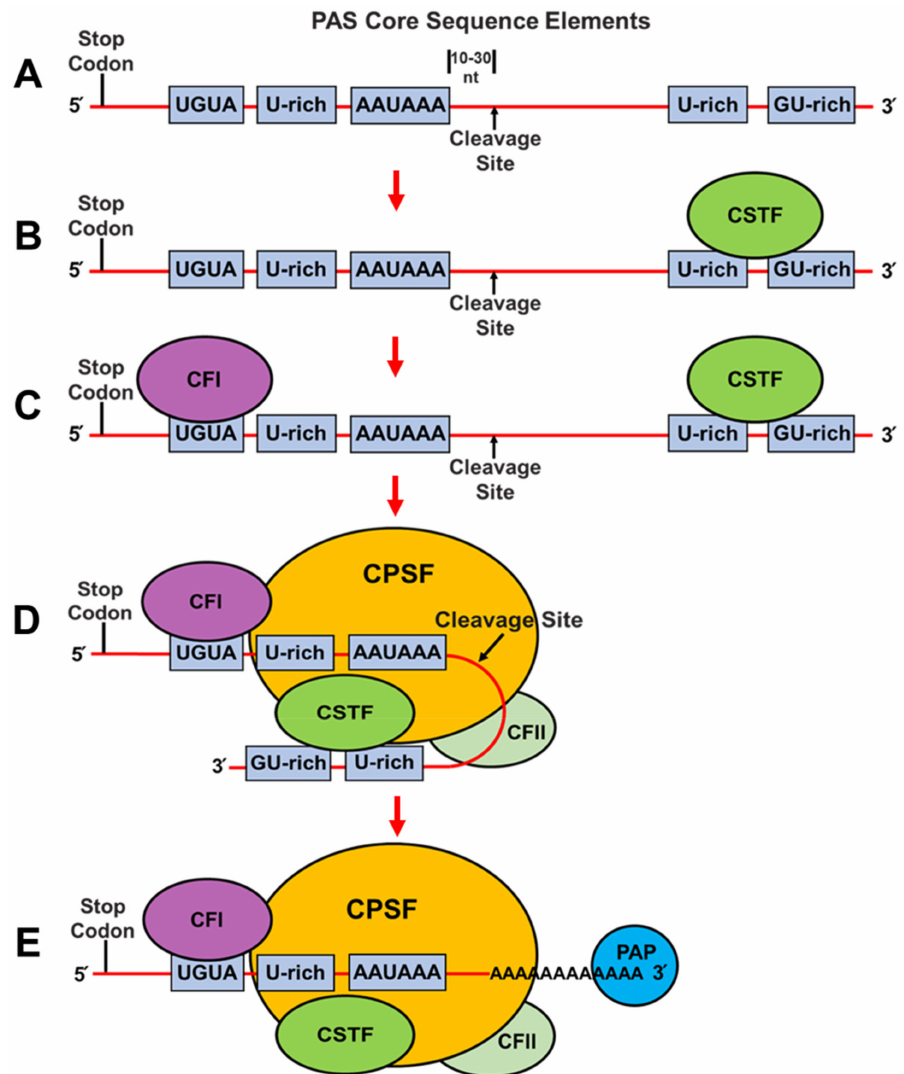
Figure 3. Schematic representation of core sequence elements and factors involved in cleavage and polyadenylation. ( A ) Cleavage and polyadenylation are regulated by cis -elements which include the AAUAAA hexamer, U-rich elements and UGUA elements upstream and U-rich and GU-rich elements located downstream from the hexamer, respectively. ( B – E ) Depicted are the stepwise interactions of the CSTF (cleavage and stimulation factor), CFI (cleavage factor I), CPSF (cleavage and polyadeny- lation specificity factor), CFII (cleavage factor II) complexes, and PAP (poly(A) polymerase) with specific cis -elements and with each other [32–35]. More details regarding the individual complexes and their specific interactions are given in the